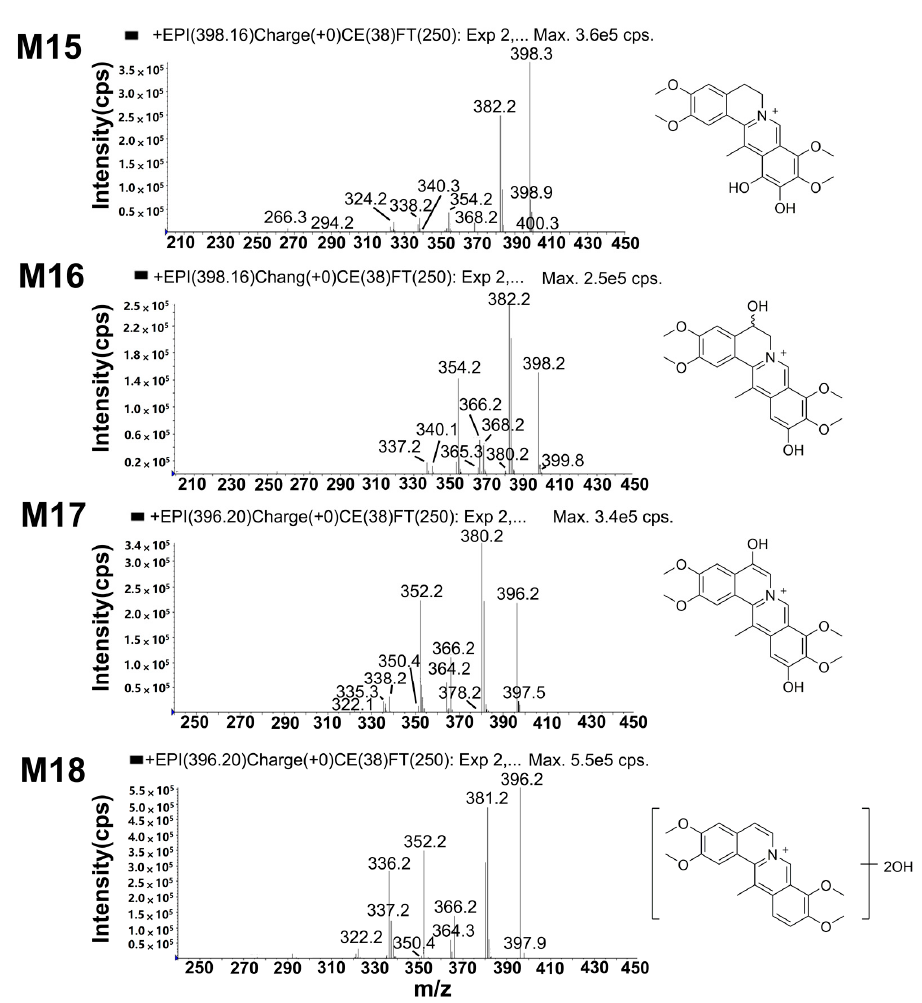
Figure 7. The mass spectrometry (MS 2 ) spectra of di-hydroxylated metabolites (M15 and M16) and metabolites (M17 and M18) produced by di-hydroxylation and dehydrogenation.